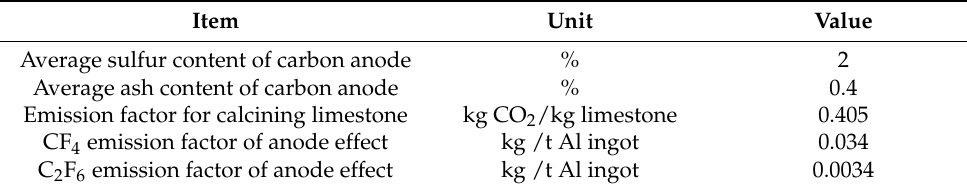
Table 5. The parameters of anode consumption, calcining limestone, and anode effect [28][32][44]. Item